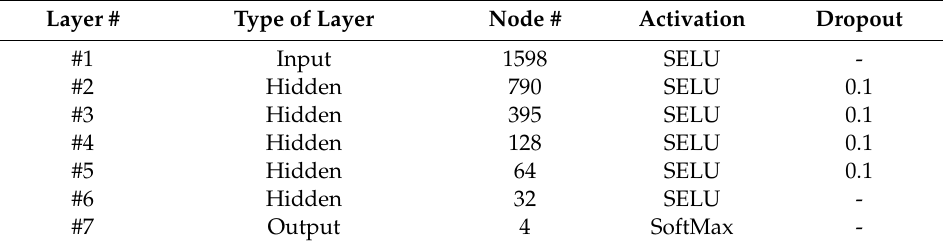
Table 3. The architecture of the deep neural network (DNN) used for fault